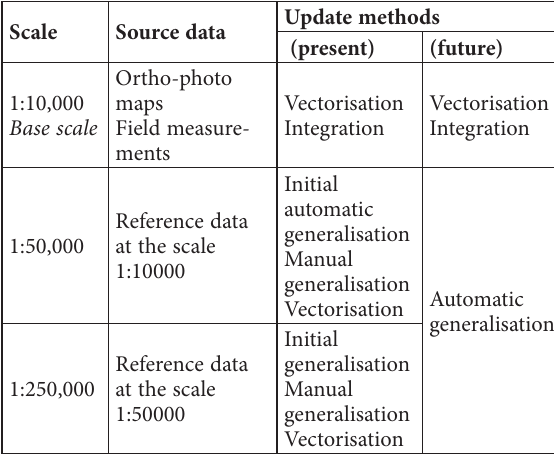
Table. Updating spatial reference data in Lithuania